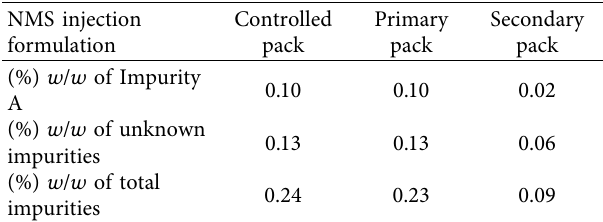
Table 12: Accelerated photostability study of NMS injection studied for 10 days using three pack